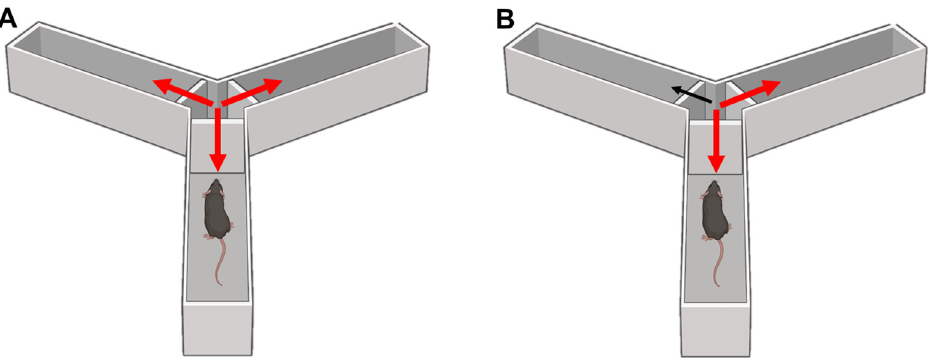
Figure 10. Y-maze test. Working memory is evaluated by measuring spontaneous alternation. In ( A ), red arrows correspond to the normal consecutive exploration of all three arms. In ( B ), the black arrow shows the corresponding arm’s low exploration, indicating spontaneous alternation and working memory problems.